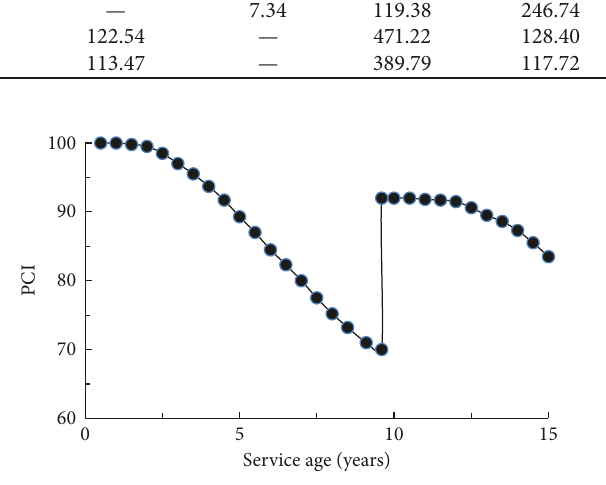
Figure 3: The change of PCI with age (maintenance event occurs at 10years). Table 2: Energy consumptions of producing 1000m 3 coarse-graded asphalt (CGA) mixture. Equipment